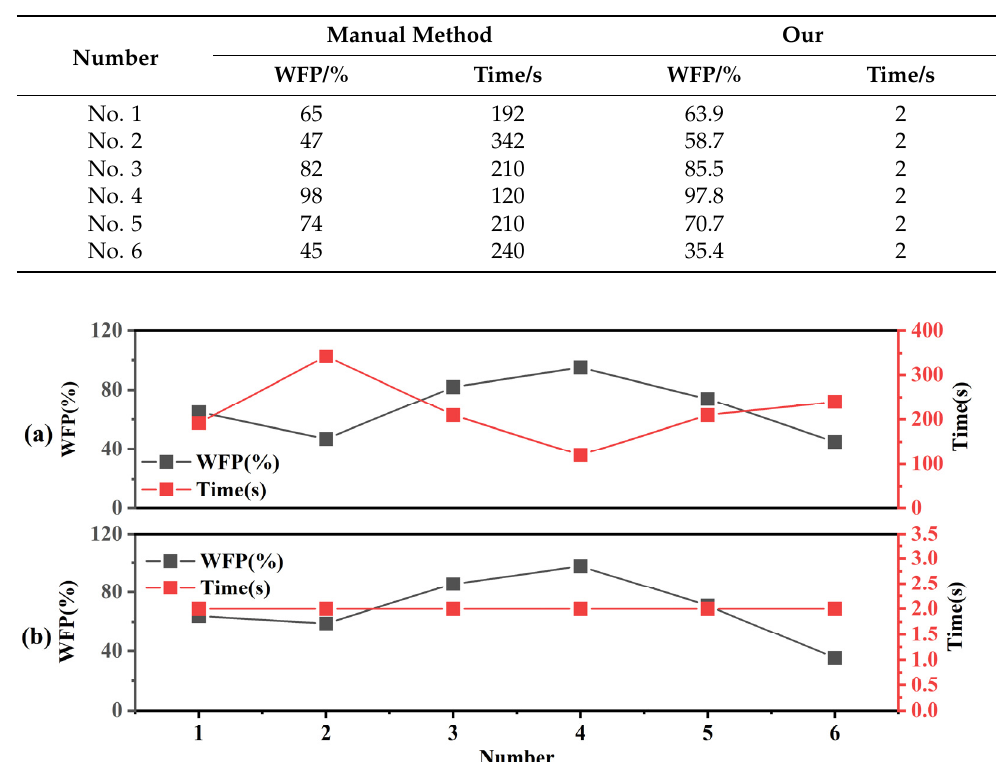
Figure 13. The relationship between measurement speed and WFP: ( a ) Manual method; ( b ) Our method.